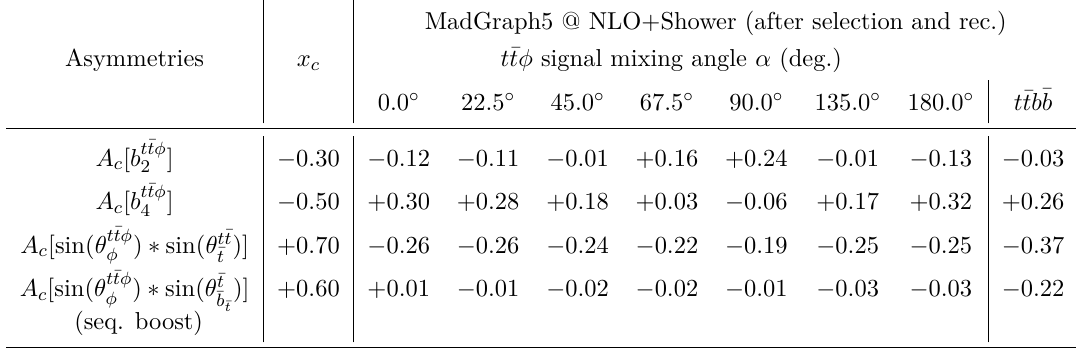
Table 2 . Asymmetries for the t ¯ tφ signal as a function of the mixing angle α , as well as for the dominant background t ¯ tb ¯ b after event selection and kinematic reconstruction, are shown for several observables. The variable x c represent the point chosen for the calculation of the asymmetry while A c is the asymmetry relative to that point. Significant differences between the asymmetries for the pure scalar ( α = 0 . 0 ◦ ) and pseudo-scalar ( α = 90 . 0 ◦ ) cases are observed for several